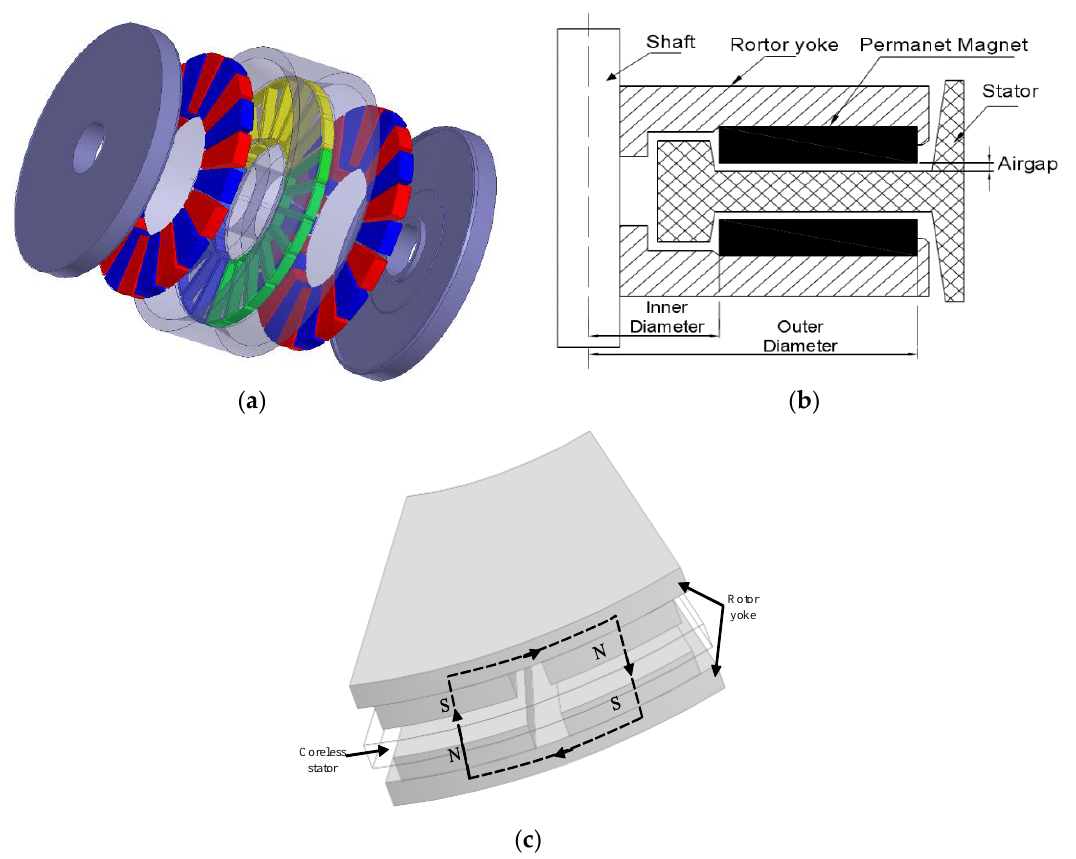
Figure 1. Axial flux permanent magnet synchronous generator (AFPMSG) configuration without the stator core and simulation model. ( a ) Assemble model; ( b ) Ironless stator structure; ( c ) simulation model.